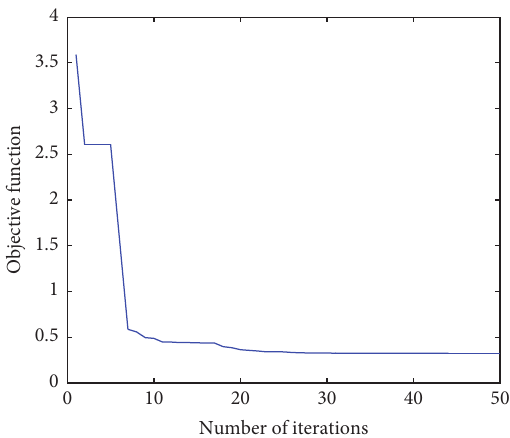
Figure 5: Convergence process of the objective function for the spatial 6-strut tensegrity